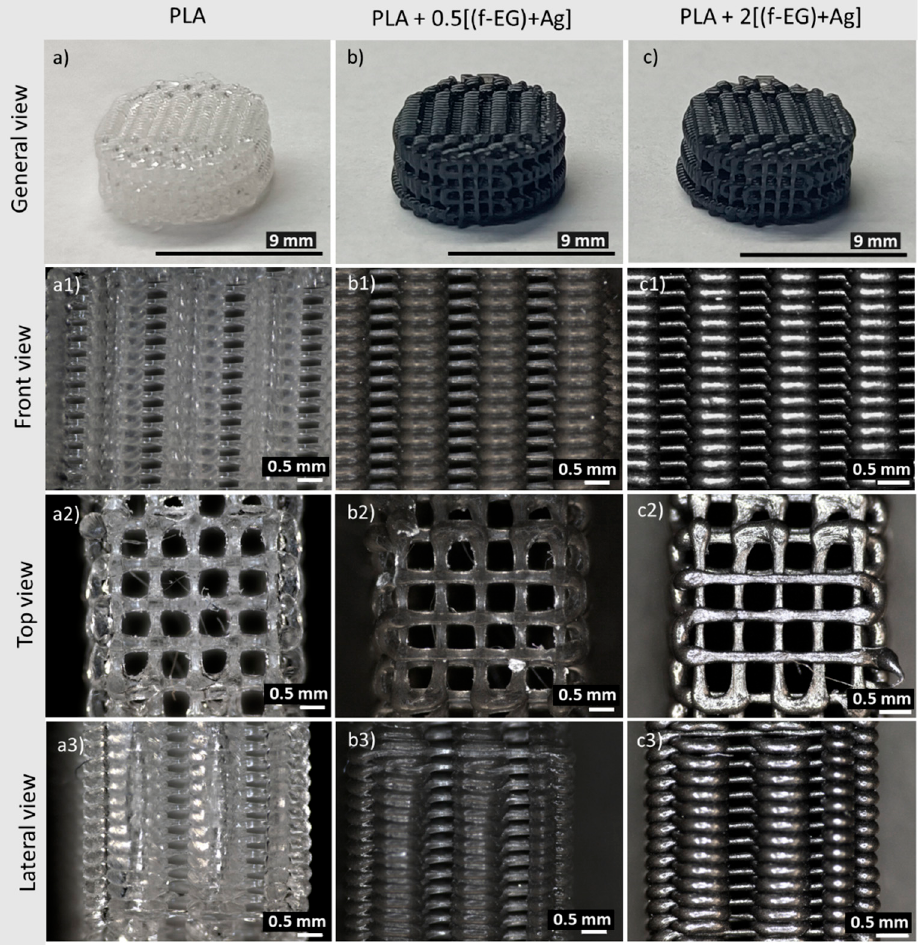
Figure 3. Three-dimensional-printed scaffolds: general view ( a —PLA; b —PLA+0.5[(f-EG)+Ag]; c — PLA+2[(f-EG)+Ag]); higher magnification ( a1 – a3 —PLA; b1 – b3 —PLA+0.5[(f-EG)+Ag] and c1 – c3 — PLA+2[(f-EG)+Ag]) from front, top, and side perspectives.